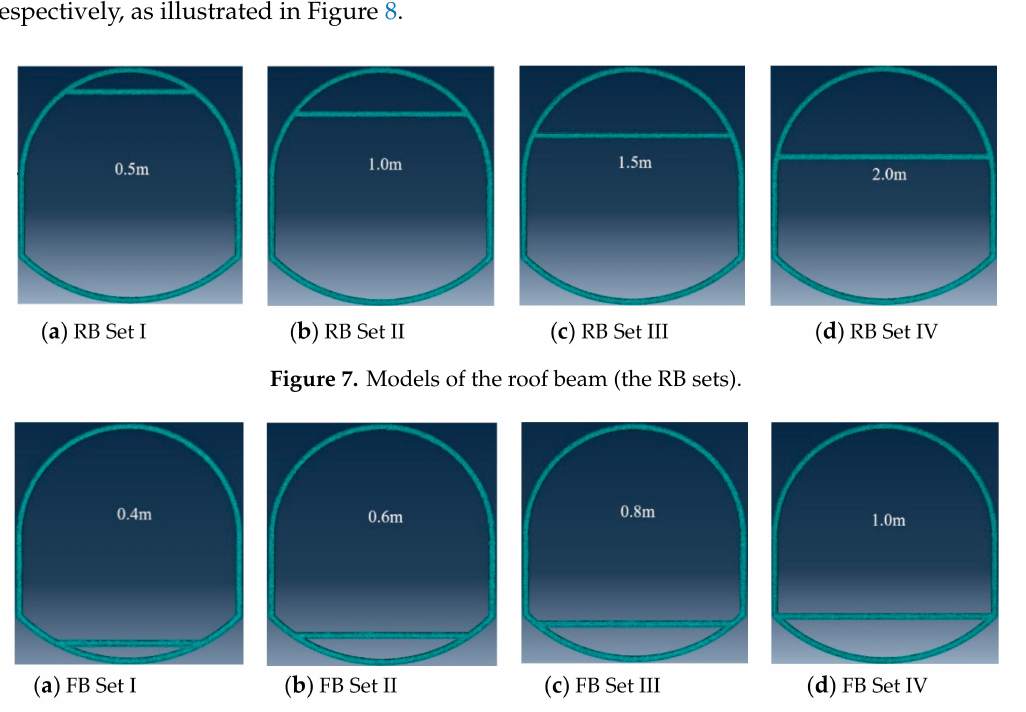
Figure 8. Models of the floor beam (the FB sets).